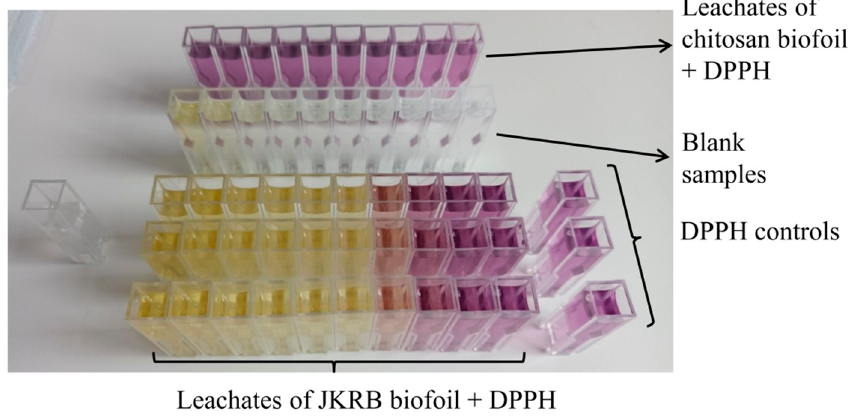
Figure 3. An example of a DPPH assay executed on chitosan (blank) and JKRB biofoils using 50% ethanol (aq) as a food simulant. Different dilutions of leachates of JKRB biofoil to which DPPH was added were tested in three parallels. Different dilutions of leachates of chitosan (blank) biofoil with exposure to DPPH reagent were tested in one parallel. Blank samples (leachates of JKRB biofoil to which reagent solvent—methanol was added) were also measured to subtract the absorbance corresponding to the color of the JKRB biofoil leachates themselves. Moreover, a blank for the spectrophotometer and 3 DPPH controls were prepared.